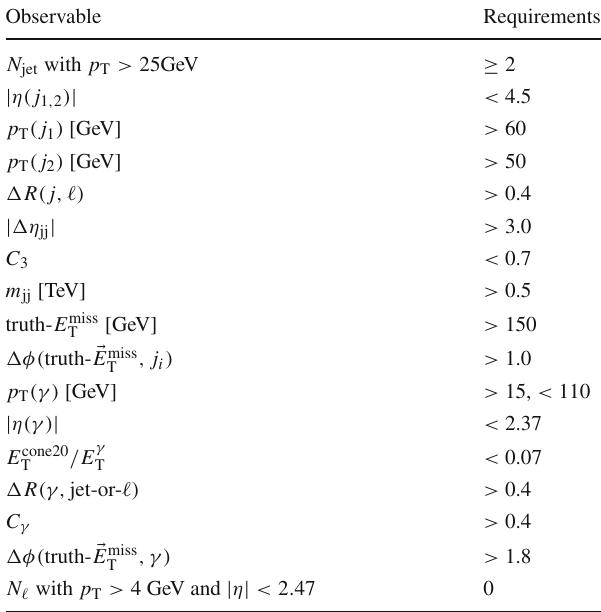
Table4 Fiducial-volumedefinitionfortheEW Z γ + jetscross-section measurement